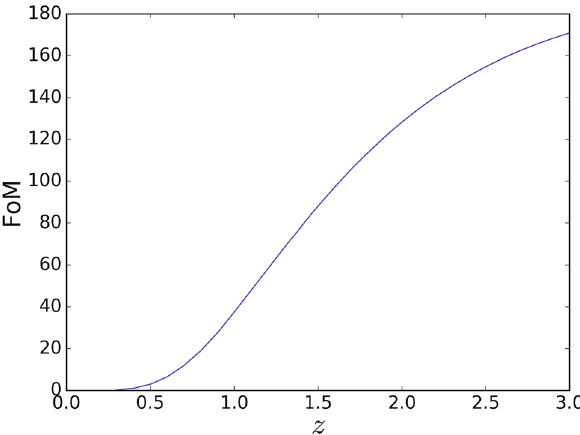
Fig. 14 The FoM variation with z . This Figure shows the correspond- ing value of FoM under the condition that if the detecting range reach redshift z . The result is based on